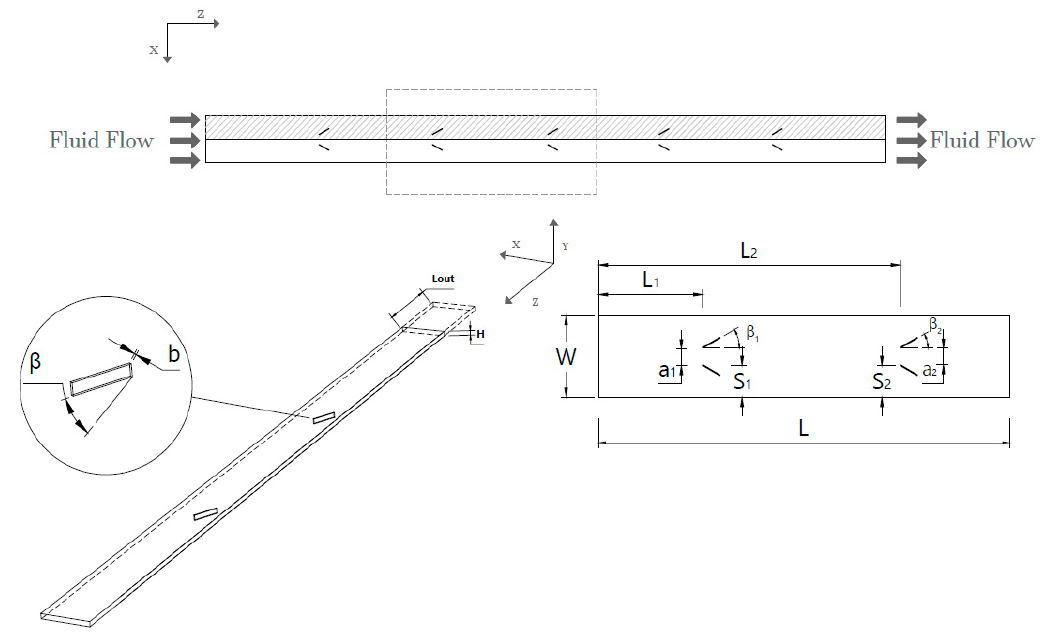
Figure 1. The physical model and the computational domain. Table 1. List of various microchannel